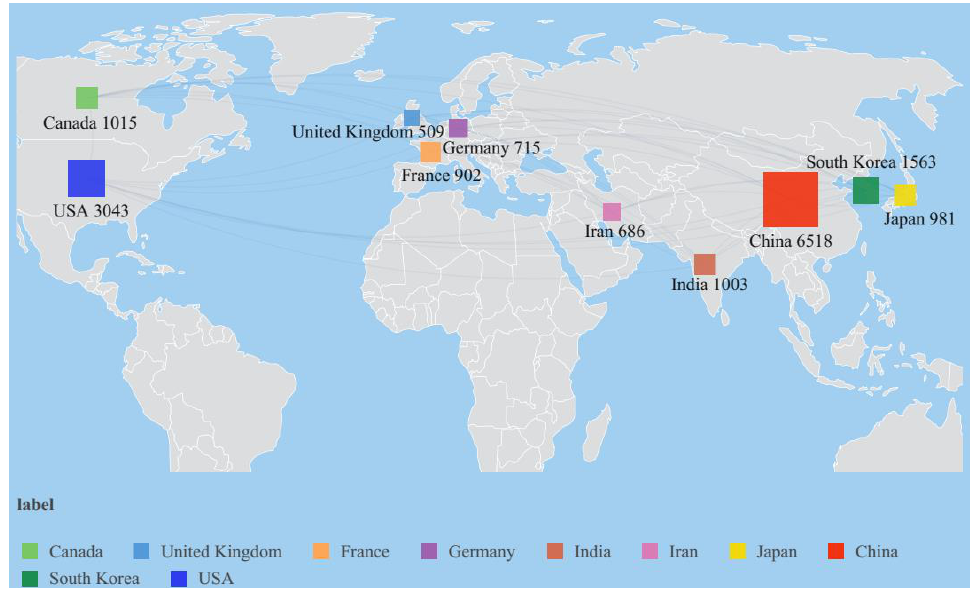
Table 4. Information on the top 10 prolific countries in the field of PEMFC.